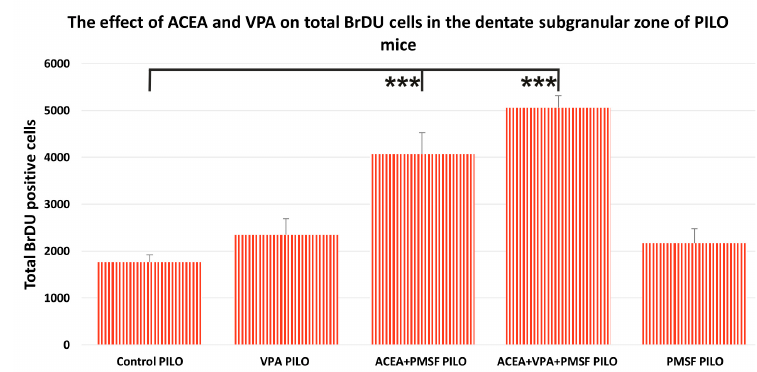
Figure 2. The numbers of cells represent an estimate of the total number of positively labeled cells in the subgranular zone in both hemispheres. The results were analyzed using one-way analysis of variance (ANOVA) followed by Dunnett’s test for multiple comparisons. Each bar represents the mean for five mice; error bars are S.E.M. (*** p < 0.001).